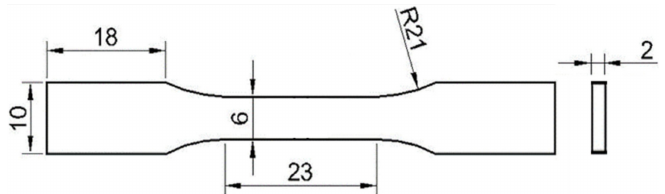
Figure 12. Schematic diagram of specimens for room-temperature tensile test (units: mm).